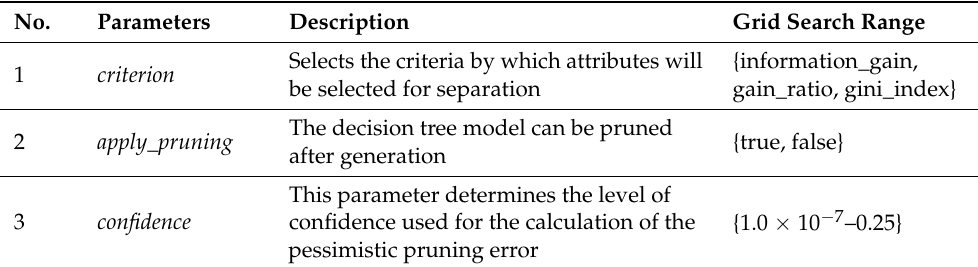
Table 5. DT model parameter